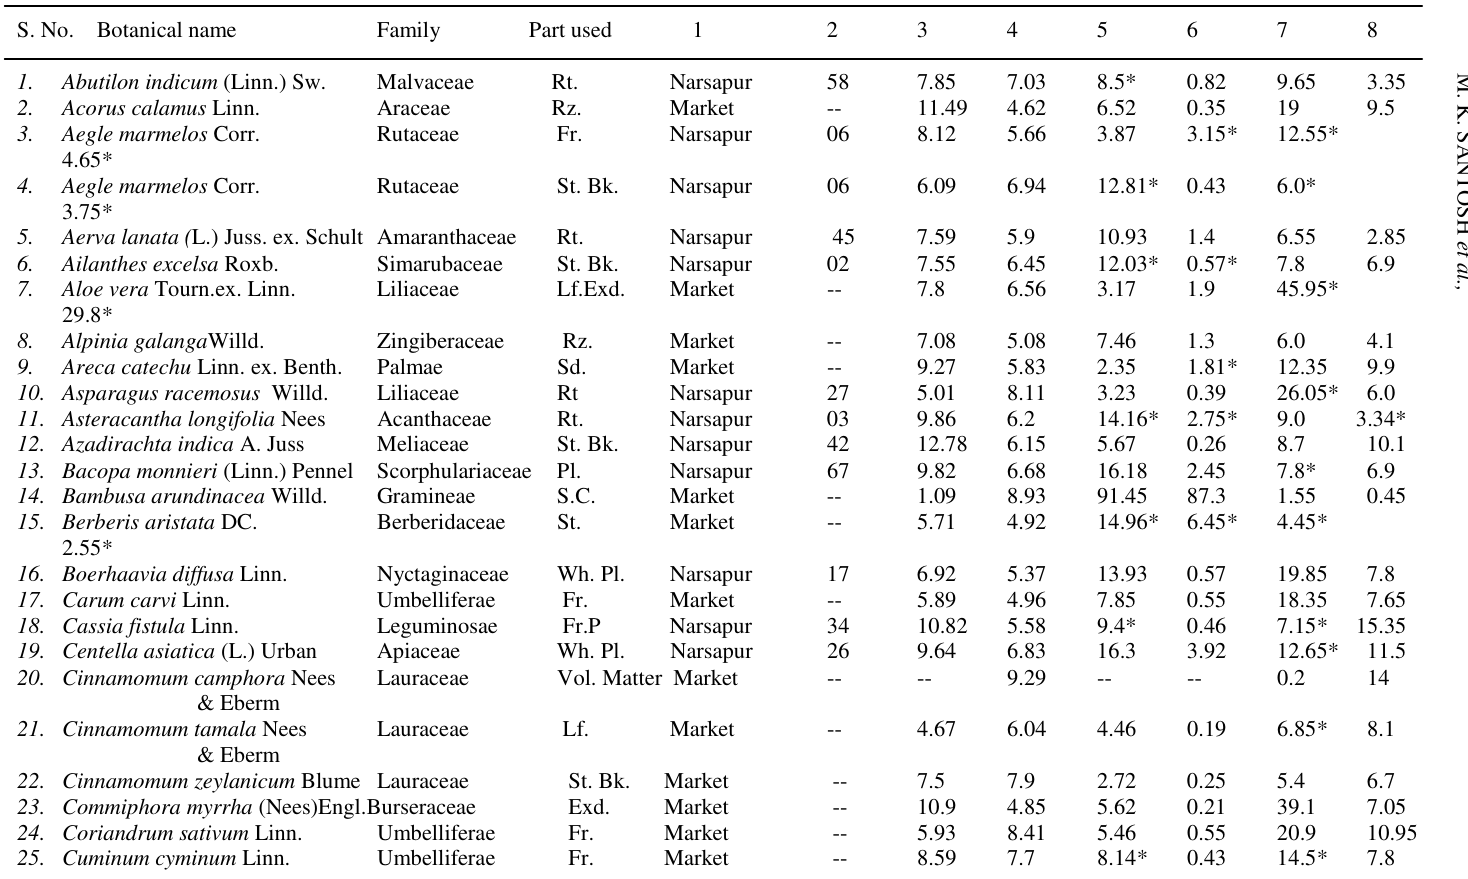
Table – 1: Results of physico-chemical study S. No. Botanical